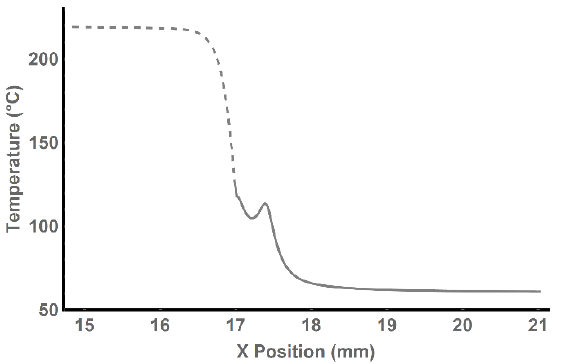
Figure 7. Temperature distribution in the material during printing (nozzle outlet is located on position 17.3 on the x -axis).